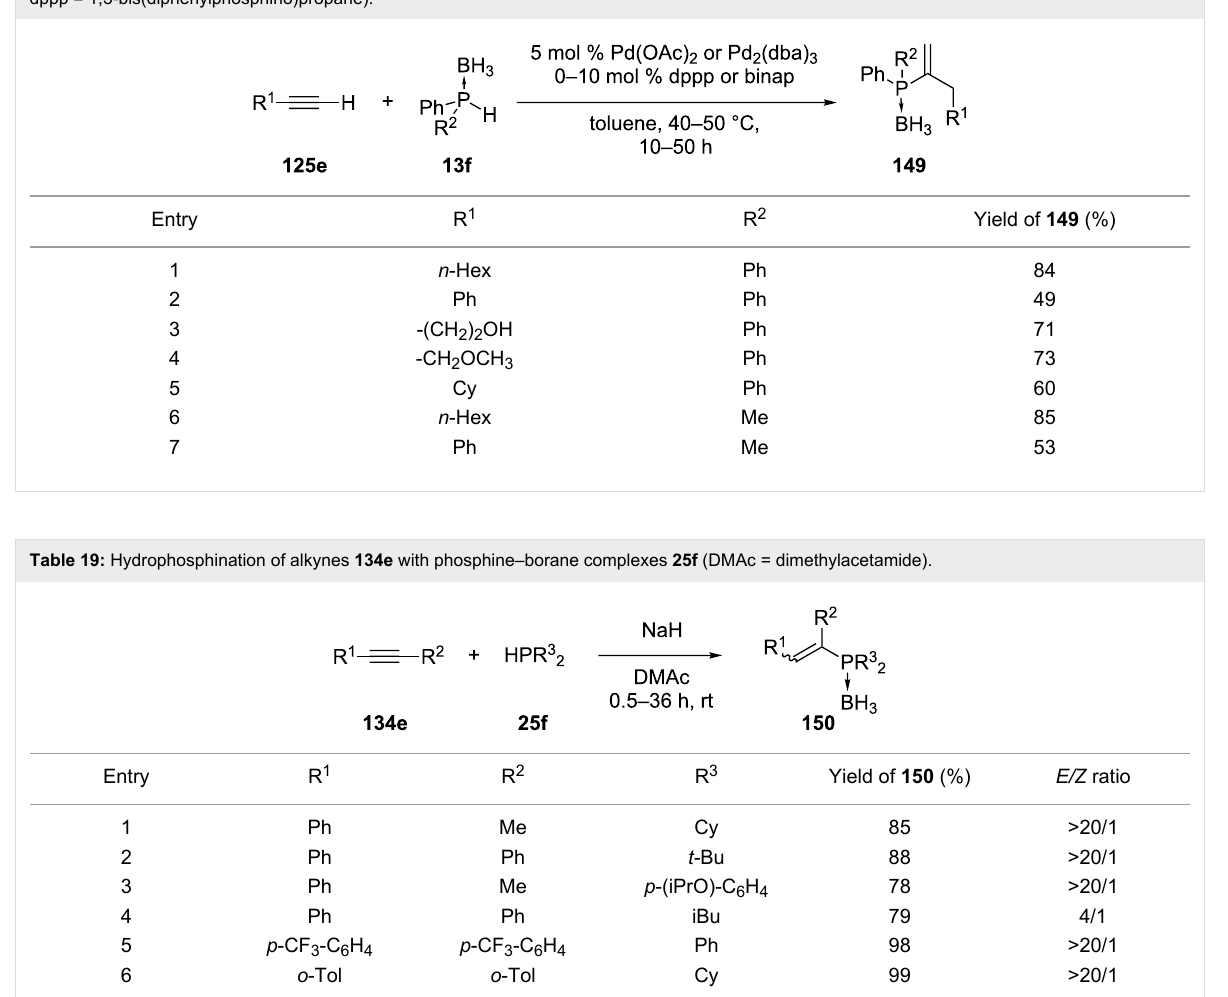
Table 18: Hydrophosphination reactions of terminal alkynes 125e with phosphine boranes 13f using a Pd catalyst (dba = dibenzylideneacetone, dppp = 1,3-bis(diphenylphosphino)propane).